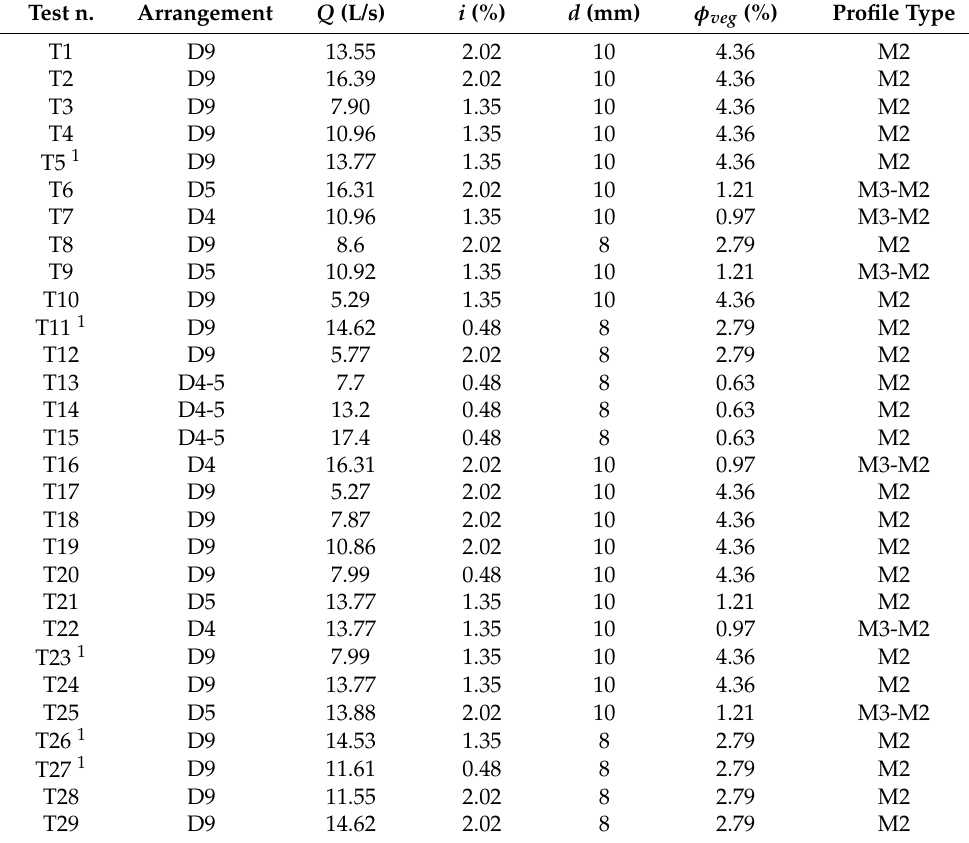
Table 1. Characteristic parameters and results of the experiments. Test